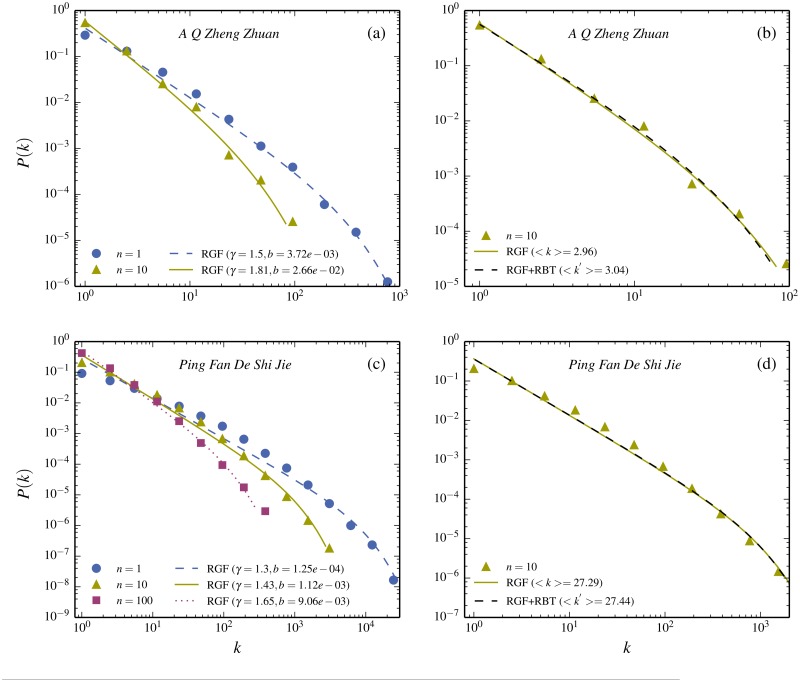
Size dependence of novels written in Chinese characters.The same two novels as in Fig 2 are divided into parts. The frequency distribution of a full novel is compared to the one of a part. (a) P(k) for A Q Zheng Zhuan (filled dots) is compared to the distribution for a typical 10th-part (filled triangles). Here the word typical means an average distribution obtained by taking many different 10th with different starting points. These two functions have quite different shapes. However, the shapes of both are equally well predicted by RGF (curves with dashed and full lines). (b) The distribution of the 10th-part, which can to very good approximation be trivially obtained from the full book by just randomly removing 90% of the words from the full book. This corresponds to the dashed curve which is almost identical to the RGF-prediction and both correspond very well to the data. (c-d) The same features for the novel Ping Fan De Shi Jie. Note that the 10th-part agrees better with RGF than the full novel.